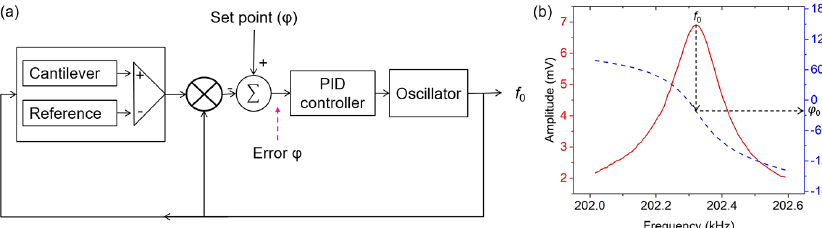
Figure 10. (a) Phase-locked-loop setup for resonance tracking by employing (b) symmetric amplitude shape with monotonic phase